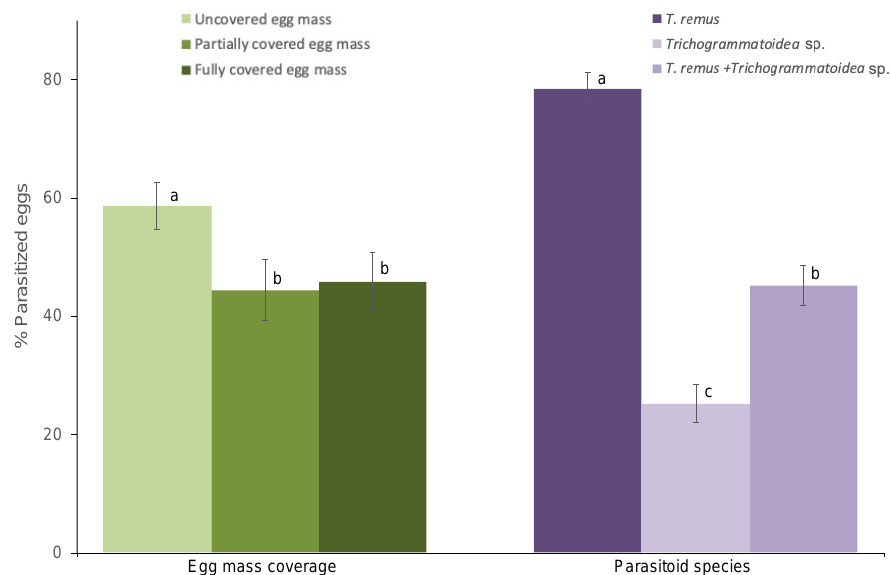
Figure 1. Egg parasitism of Spodoptera frugiperda (% ± SE) by T. remus , Trichogrammatoidea sp.; and combined T. remus + Trichogrammatoidea sp. of fully covered, partially covered, and uncovered egg masses. Bars bearing different letters within column groups were significantly different (Bonferroni test, α = 0.05).